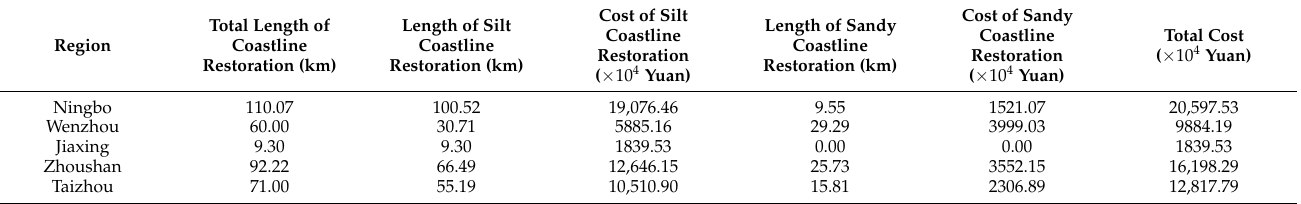
Table 1. Direct cost of the coastline ecological restoration project in five coastal cities of